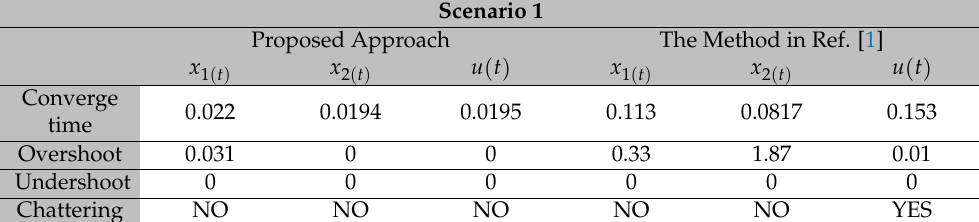
Table 1. Comparing the responses of the DBC system under the conditions of scenario 1. (cid:1)